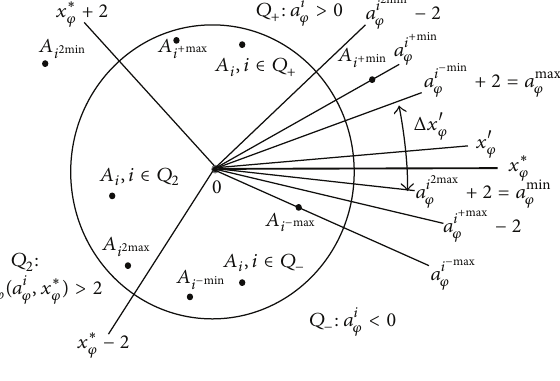
Figure 4: Illustration for Lemma